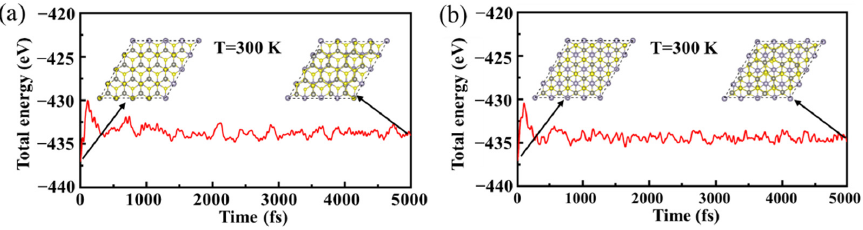
Figure 4. Fluctuation of the total free energy of H3 ( a ) and H4 ( b ) heterojunction during AIMD simulations.